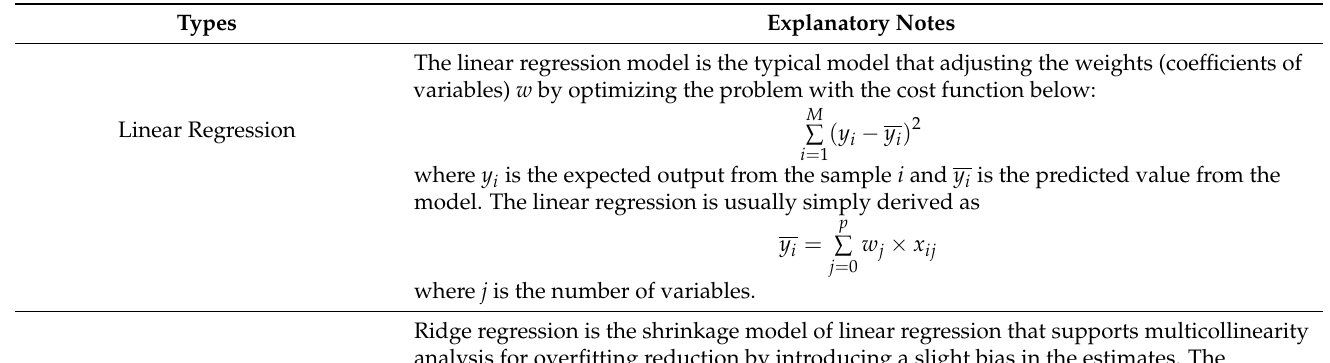
Table 2. Types of Regression